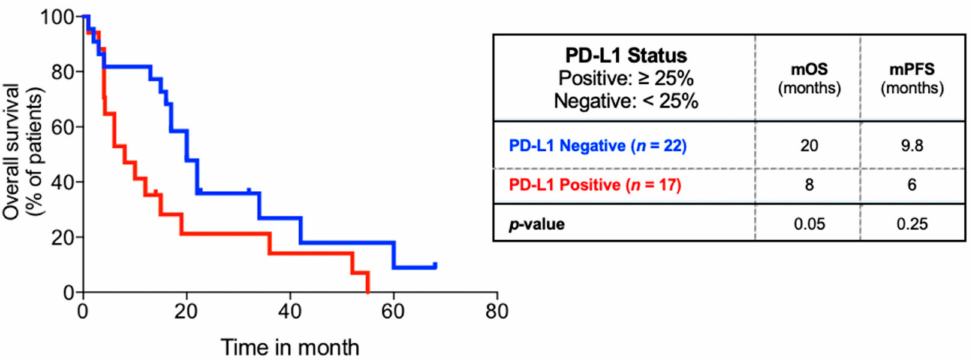
Figure 3. Overall survival of subgroup of 39 patients comparing PD-L1 status. Kaplan–Meier overall survival analysis of subgroup of patients with PD-L1 status available comparing PD-L1